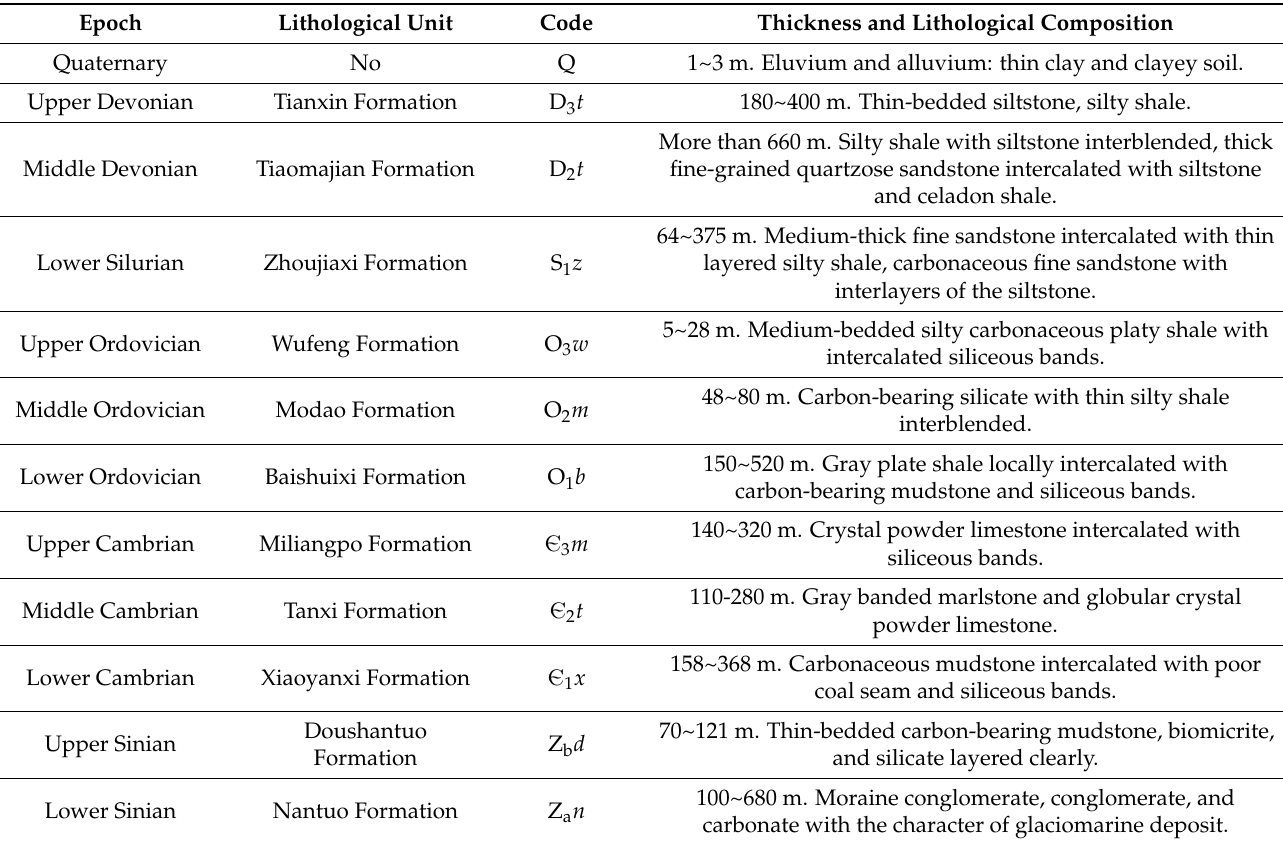
Table 1. Detailed stratigraphy of the Liaojiaping